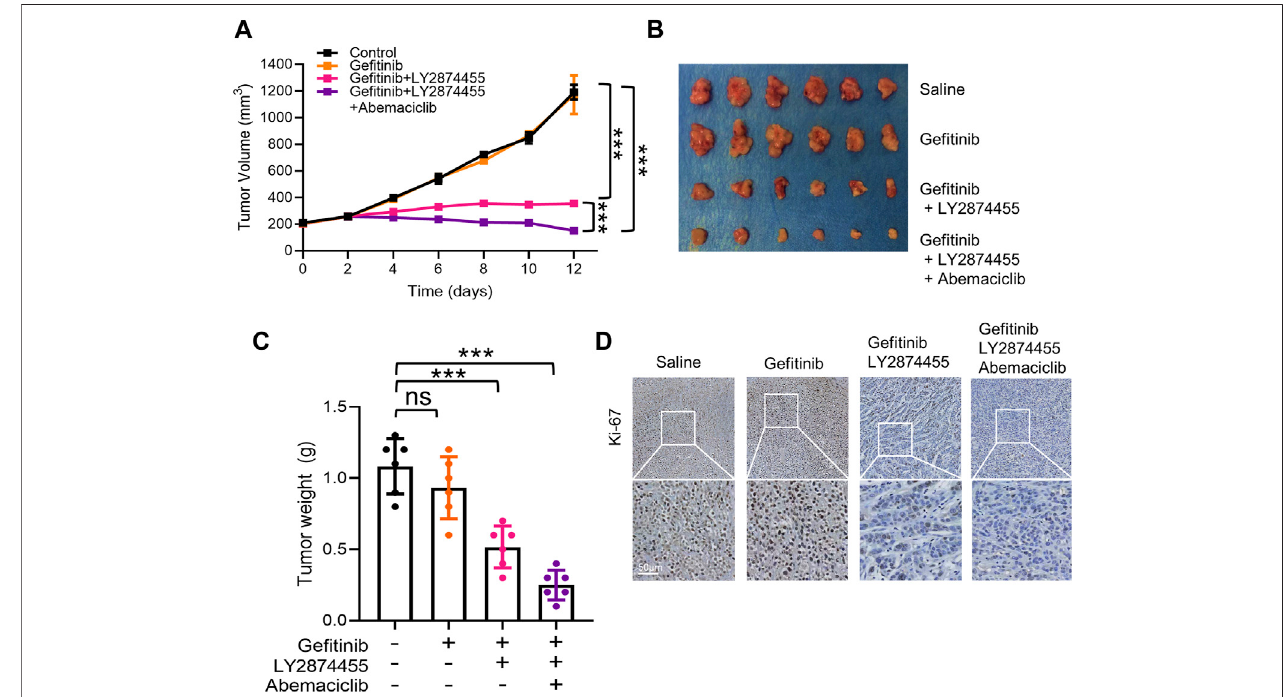
FIGURE 5 | The combination of ge fi tinib/LY2874455/abemaciclib reverses the ge fi tinib resistance induced by FGFs/CCND1 in vivo. (A) Mice bearing PC-9-4X were injected twice a week with ge fi tinib (100 mg/kg) combined with LY2874455 (3 mg/kg) or abemaciclib (50 mg/kg) or PBS by oral administration, and tumor growth wasmonitoredfor2 weeksduringtreatments(*** p < 0.001,two-wayANOVA,withTukey ’ stest).Pro fi lesoftumorgrowthduringthedrugtreatmentareshown.Foreach treatment group, data are presented as mean tumor volume (mm 3 ) ± SD, n = 6. (B) Tumors resected from each group with indicated treatment at the end of experiments are shown n = 6. (C) Tumor volume was measured using calipers. Mean ± SD tumor volumes on day 12 are shown. Each group contained 6 mice (ns, p > 0.05. *** p < 0.001, one-way ANOVA, with Tukey ’ s test). (D) Immunohistochemical staining with Ki-67 antibodies in xenograft tumors from each group. Scale bar, 50